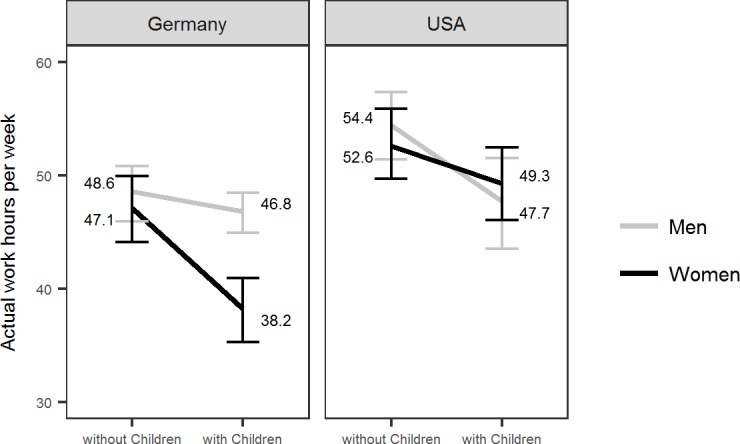
Actual work hours of German and U.S. early career researchers as a function of gender and parenthood.Figure depicts the empirical (not imputed) means. Errorbars indicate 95% bootstrap confidence intervals.